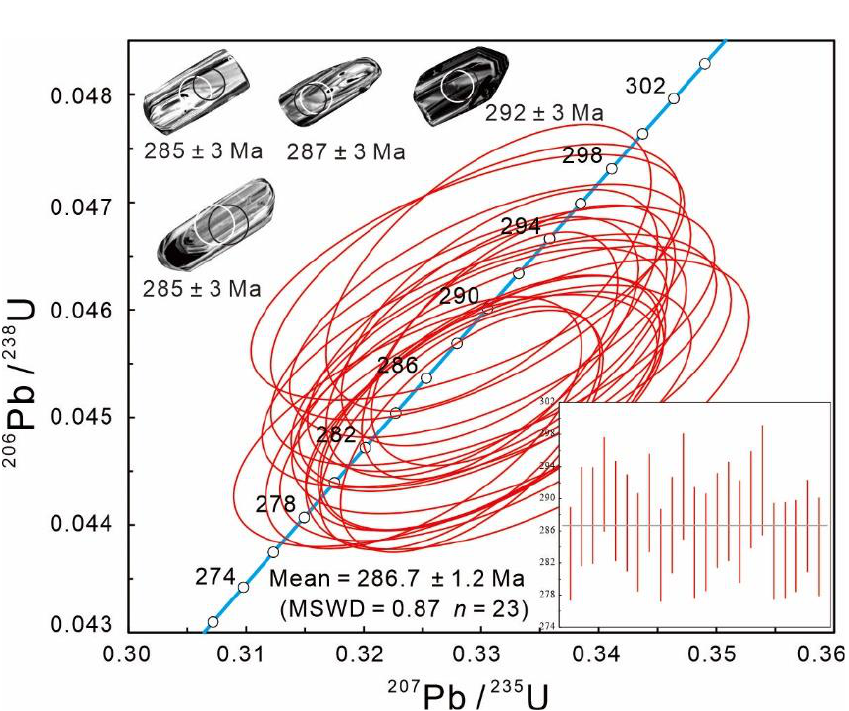
Figure 2. Zircon U-Pb concordia diagram for the sample from the Zhaojinggou monzogranite, Inner Mongolia.